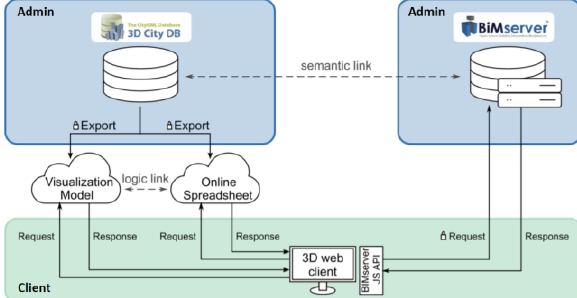
Figure 1. Architecture of the prototype- 3DCityDB4BIM,